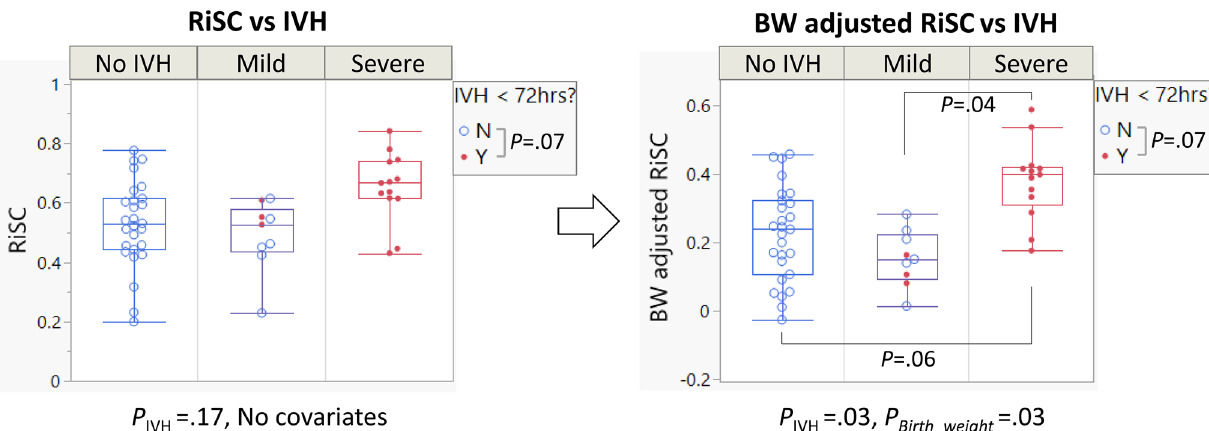
Figure 5. RiSC was higher in the severe-IVH group compared to other IVH groups after accounting for the effect of birthweight (Right panel; Tukey post-hoc test showed P = 0.04 in severe vs mild groups and P = 0.06 in severe vs no-IVH groups). Each point was based on one day of measurement. The plot on the left shows the original distribution before adjusting for body weight. The right panel shows the RiSC comparison after adjusting for the birthweight. Both the original RiSC and adjusted RiSC were marginally different in ELGA infants who were diagnosed with IVH within 72 h of life compared to controls ( P = 0.07 and 0.07, respectively). (Red dot = diagnosed with IVH within 72 h of life; Blue open circle = no IVH within 72 h of